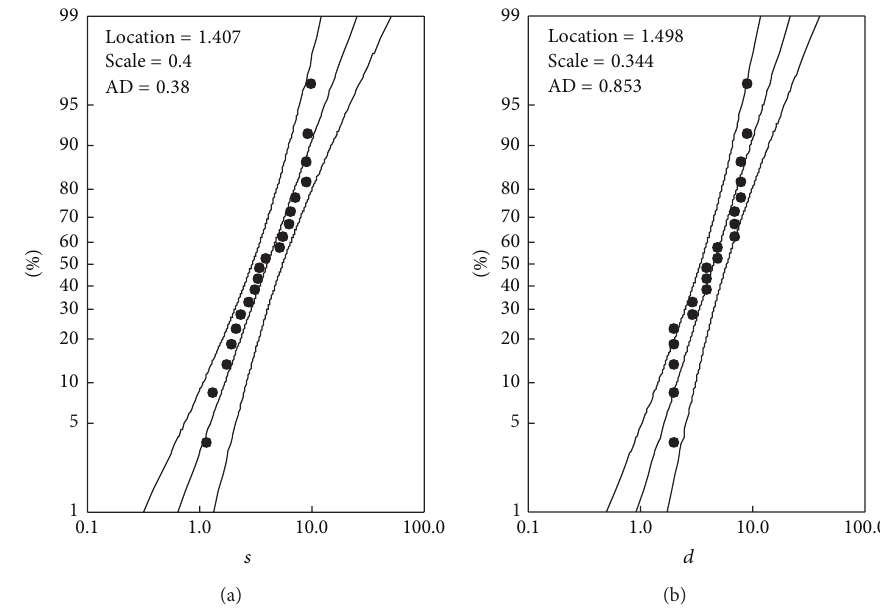
Figure 6: The probability plots for the log-logistic distribution of drought severity and duration for SPI3 series. The upper and lower solid curves represent the confidence intervals based on the location and scale parameters estimated from the data. AD corresponds to Anderson- Darling statistic.